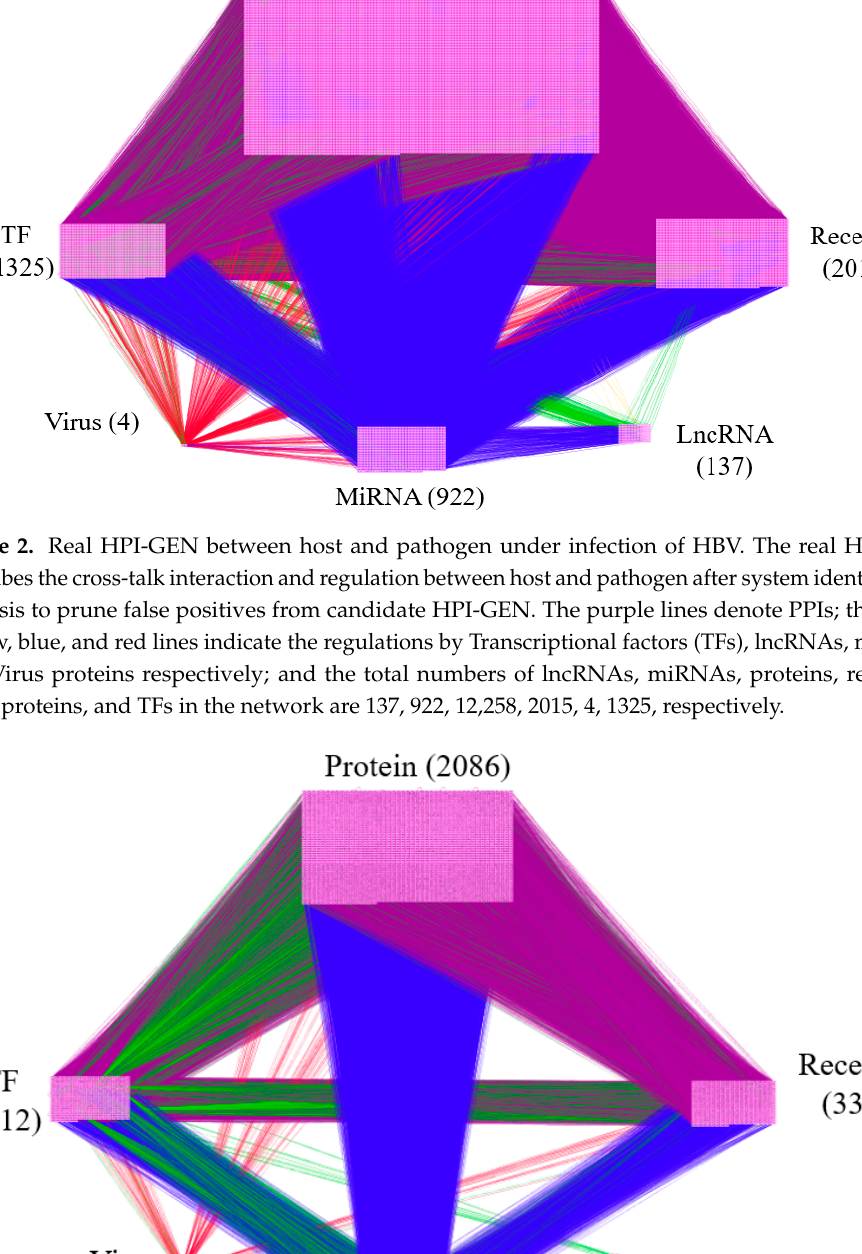
24 of 50 Figure 1. Flowchart of applying systems biology method to construct the candidate HPI-GEN, real HPI-GEN, core HPI-GEN, and core signaling pathways during the infection of HBV to identify the potential biomarker for later drug discovery repurposing. The grey blocks in the shape of a cloud indicate the online databases for constructing candidate HPI-GEN and later drug repositioning; the white diamond blocks are the corresponding data types of each database; the orange diamond blocks signify candidate protein-protein interaction network (PPIN) and gene regelation network (GRN); the blue blocks represent the input information including the raw RNA-seq data for system identification and the collected articles for BioBERT to augment the interspecies interactions and regulations in PPIN and GRN, respectively; the red blocks